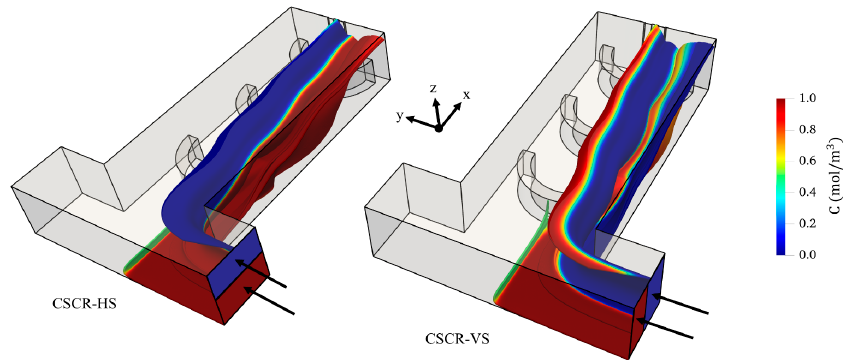
Figure 11. Mixing index vs. Re number for di ff erent inlet and injection configurations of the CSCR micromixer.